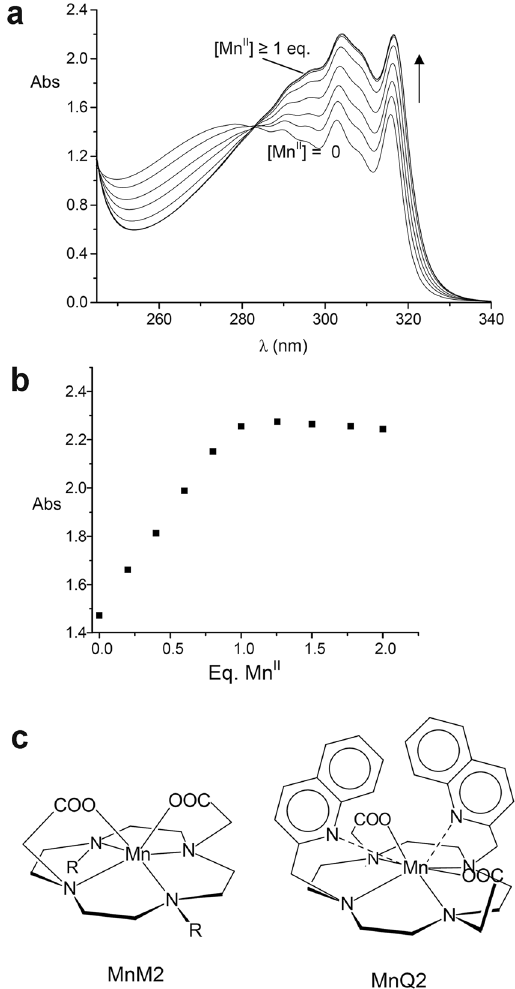
Figure 3. UV-vis spectra of H 2 Q2 ( a ) and absorbance measured at λ 316 nm in the presence of increasing amounts of Mn II (aqueous solution, pH 7.4, [H 2 Q2 = 1.1·10 − 4 M]), and proposed structures of the MnM2 and MnQ2 complexes (in MnQ2 one or both quinoline moieties can be involved in metal coordination: only the case with both the quinoline units interacting with Mn II is